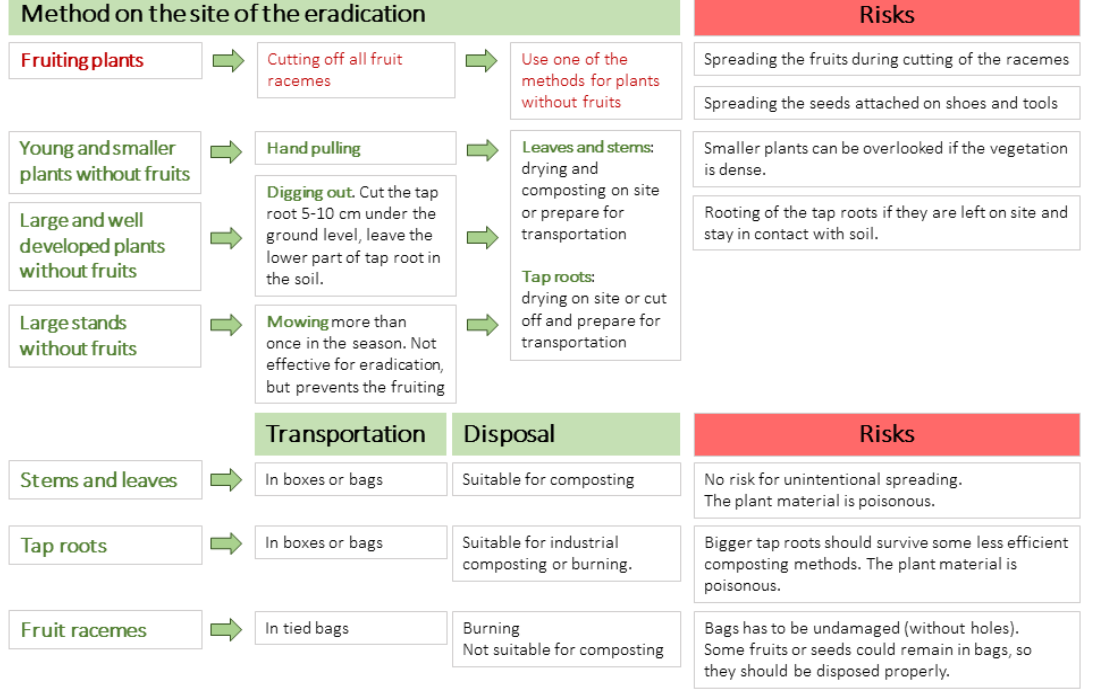
Figure 6. The protocol for eradication and disposal of collected Phytolacca americana and P. acinosa to prevent the unintended further spread.